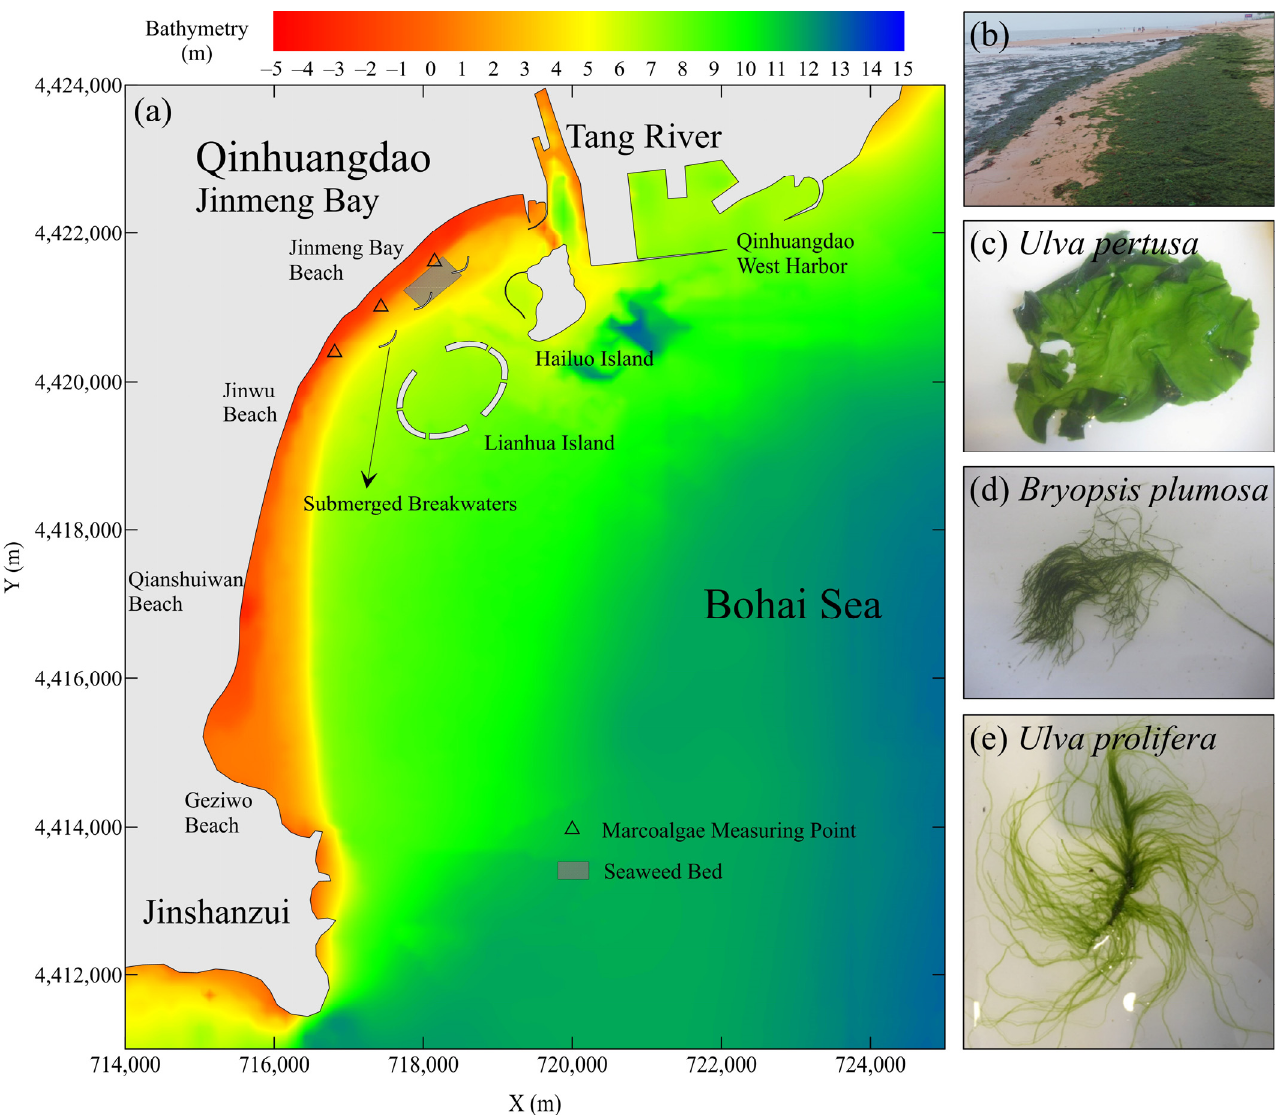
Figure 1. ( a ) Map of Jinmeng Bay, Qinhuangdao, with bathymetry. Hollow triangles are macroalgae measuring points, and the rectangular shadow area is the seaweed bed, which is the original source of the green tides; ( b ) Beached green macroalgae; ( c ) Ulva pertusa ; ( d ) Bryopsis plumose ; ( e ) Ulva prolifera .